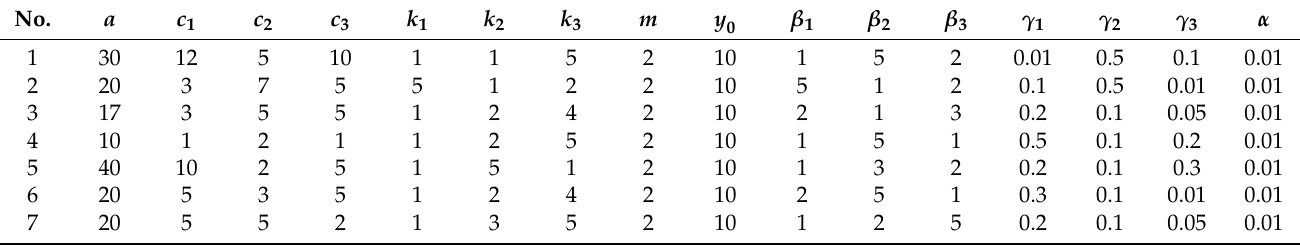
Table 8. Input data for three arbitrary agents with consideration of the green